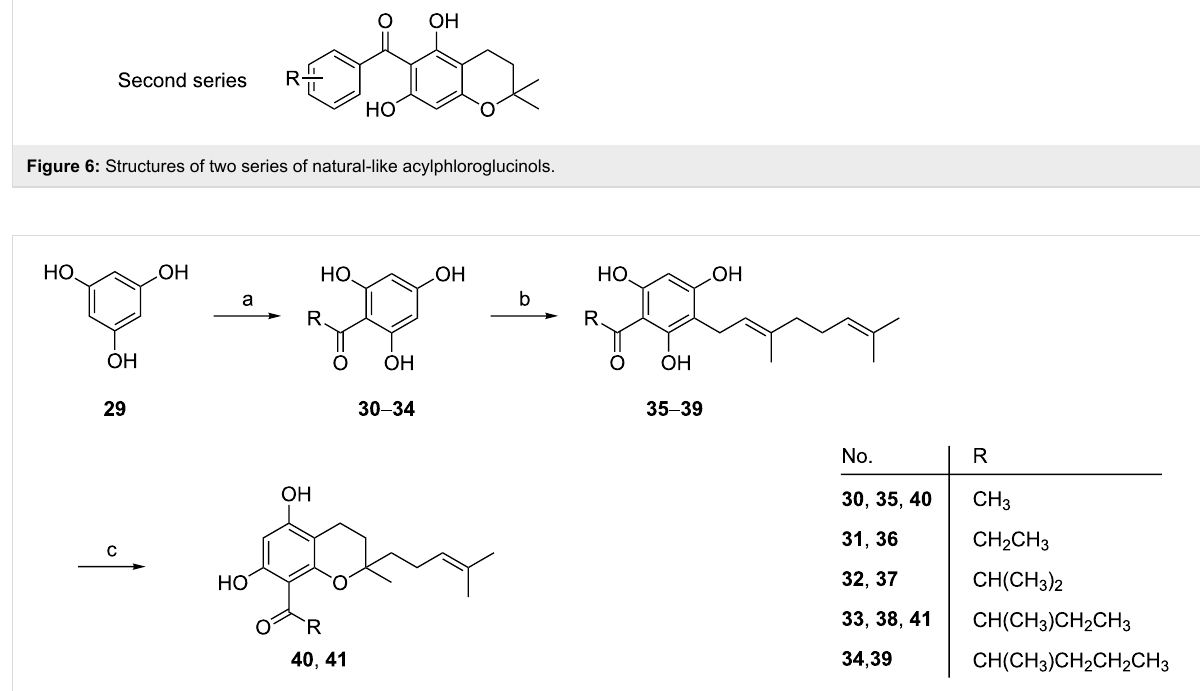
Scheme 7: Synthesis of acylphloroglucinol derivatives 35–41 . Reagents and conditions: ( a ) acyl chloride, AlCl 3 , CS 2 /PhNO 2 , 55 °, 2 h; ( b ) geranyl bromide,